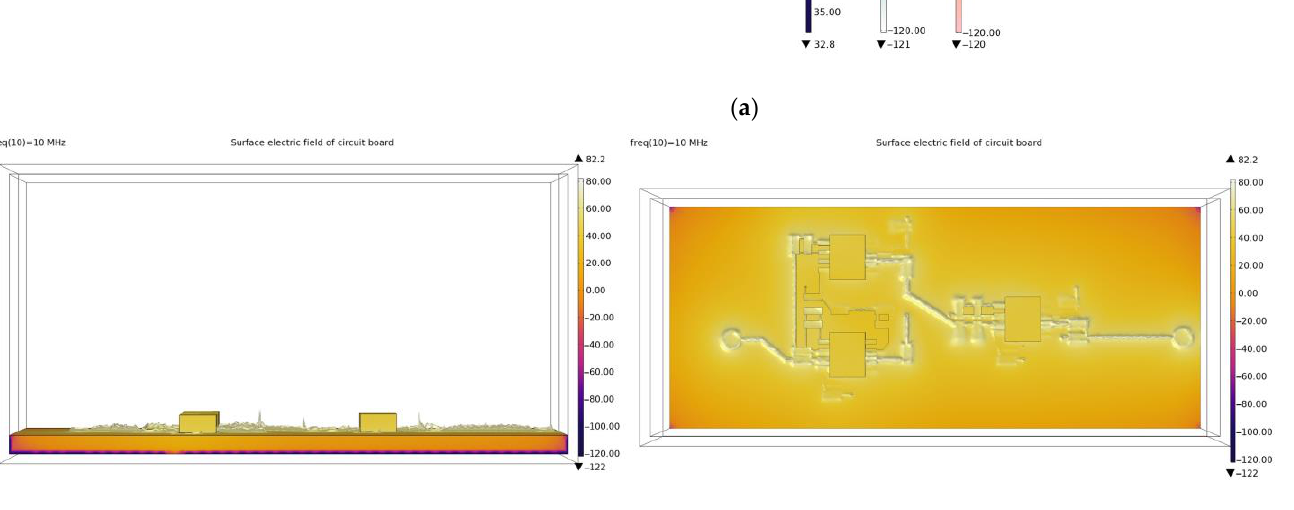
Figure 7. The response characteristics of signal conditioning circuit in the range of 1 MHz to 100 MHz simulated by COMSOL Multiphysics software. The complete manufactured prototype of the new signal conditioning sensor is shown in Figure 8. Moreover, a lithium battery charging and discharging circuit module and DC voltage stabilizing filter module have been integrated in the signal conditioning sensor, which can provide a stable and low-noise 5V 